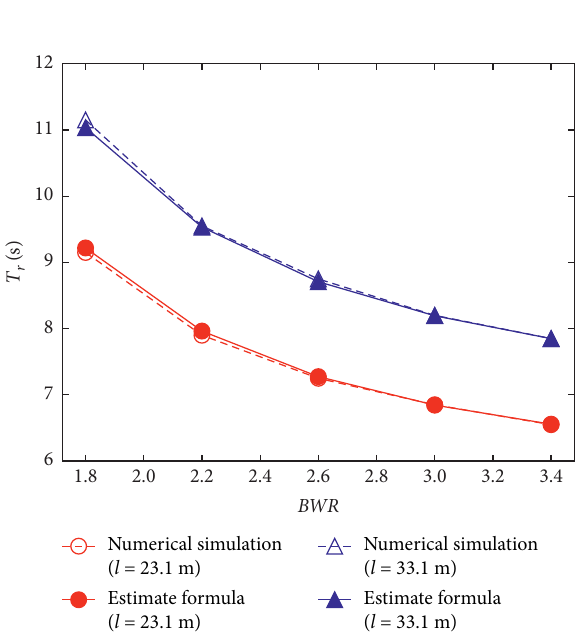
Figure 14: Comparison of estimation formula with numerical simulation of resonance